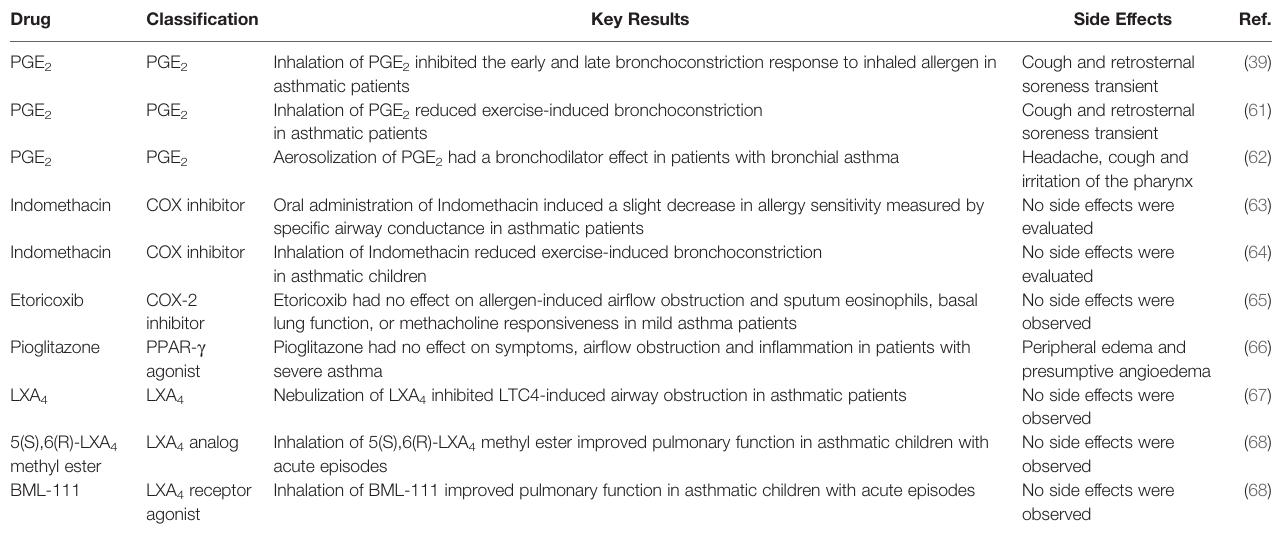
TABLE 1 | Summary of clinical studies using mediators related to arachidonic acid metabolism pathways in asthma.